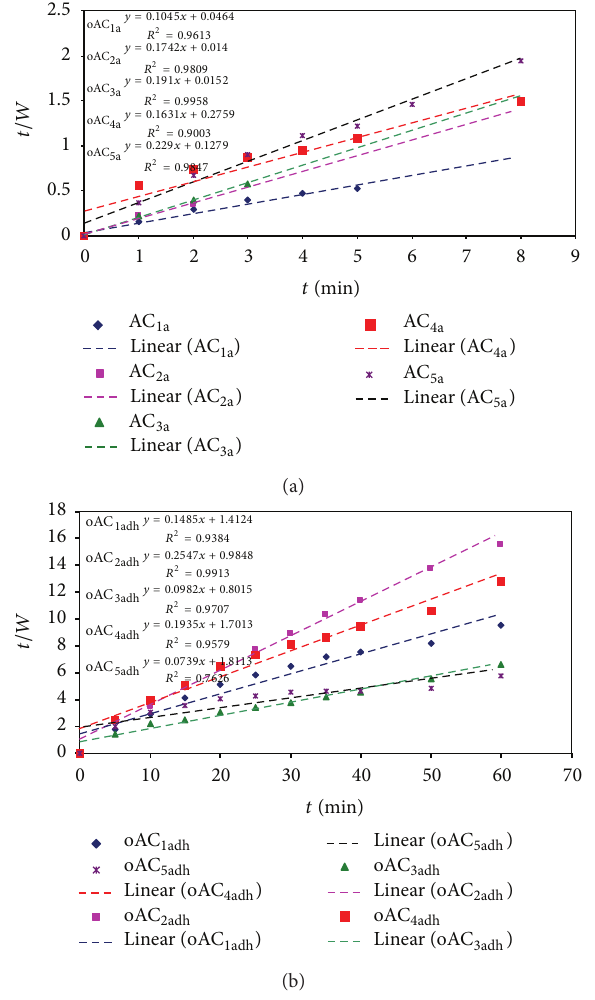
Figure 6: Plot 𝑡/𝑊 versus time according to (6) (second order kinetics) for the calcium cross-linked (AC 1a –AC 5a ) (a) and cova- lently cross-linked alginate/k-carrageenan hydrogel formulations (AC 1adh –AC 5adh ) (b).